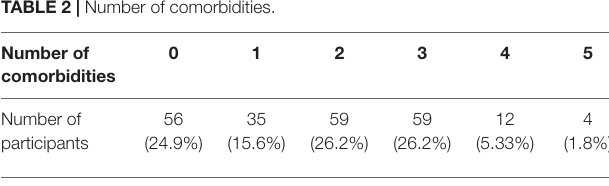
TABLE 2 | Number of comorbidities.